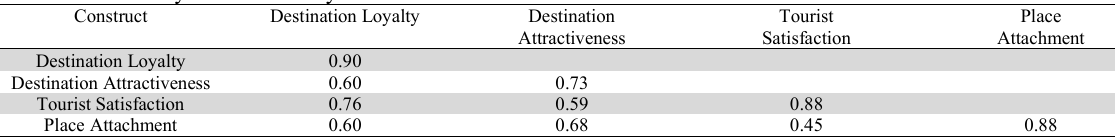
Discriminant validity index summary